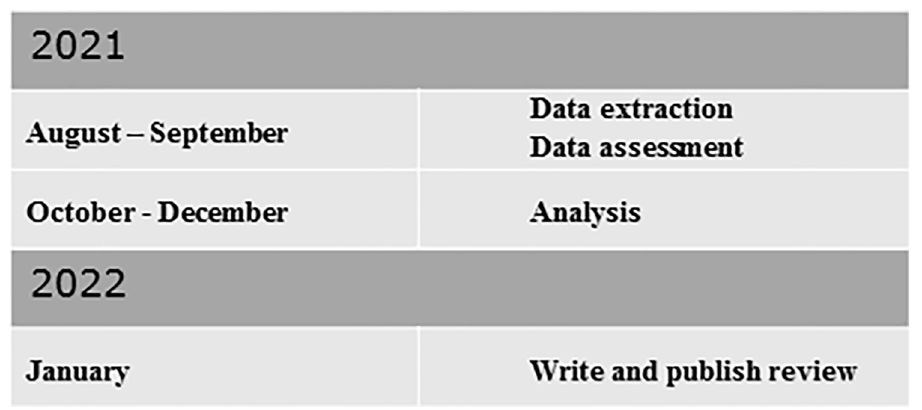
Fig 1. Timeline of the development of the scoping